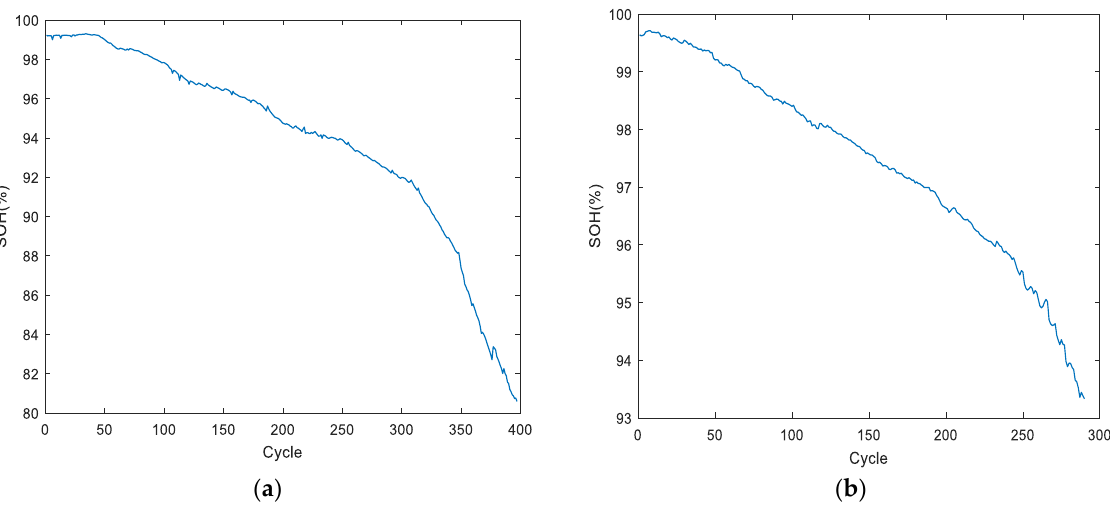
Figure 4. Measured SOH data of battery pack and cell. ( a ) Battery pack; ( b ) battery cell.